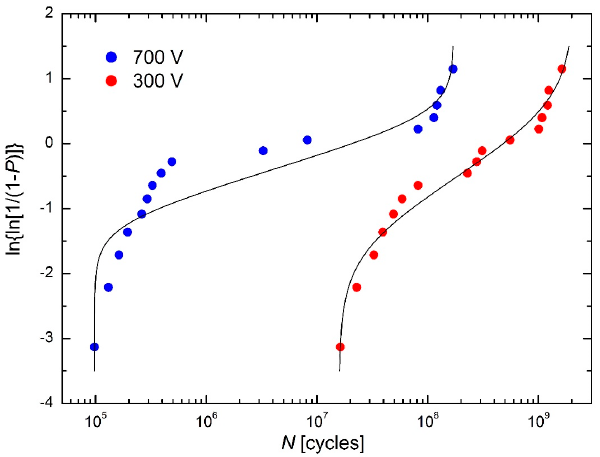
Figure 6. Weibull plots of the number of cycles to the destruction of the multilayer ceramic piezoelectric actuators at the temperature of 90 °C and the humidity of 30 % for given AC biases [11].